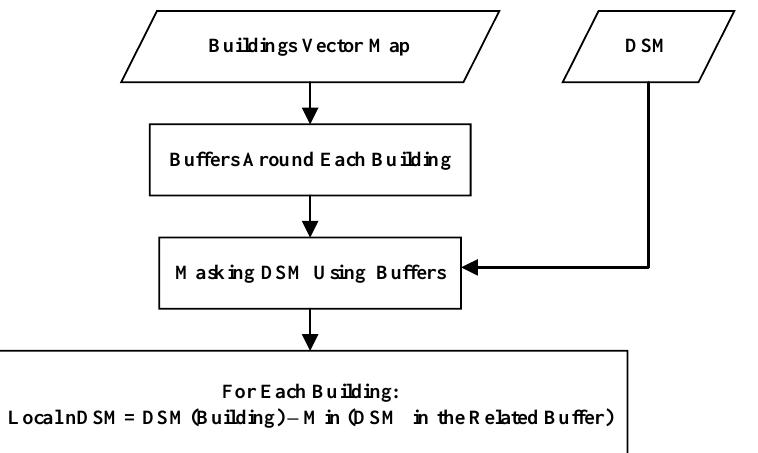
Figure 3. The flowchart of the proposed local nDSM.